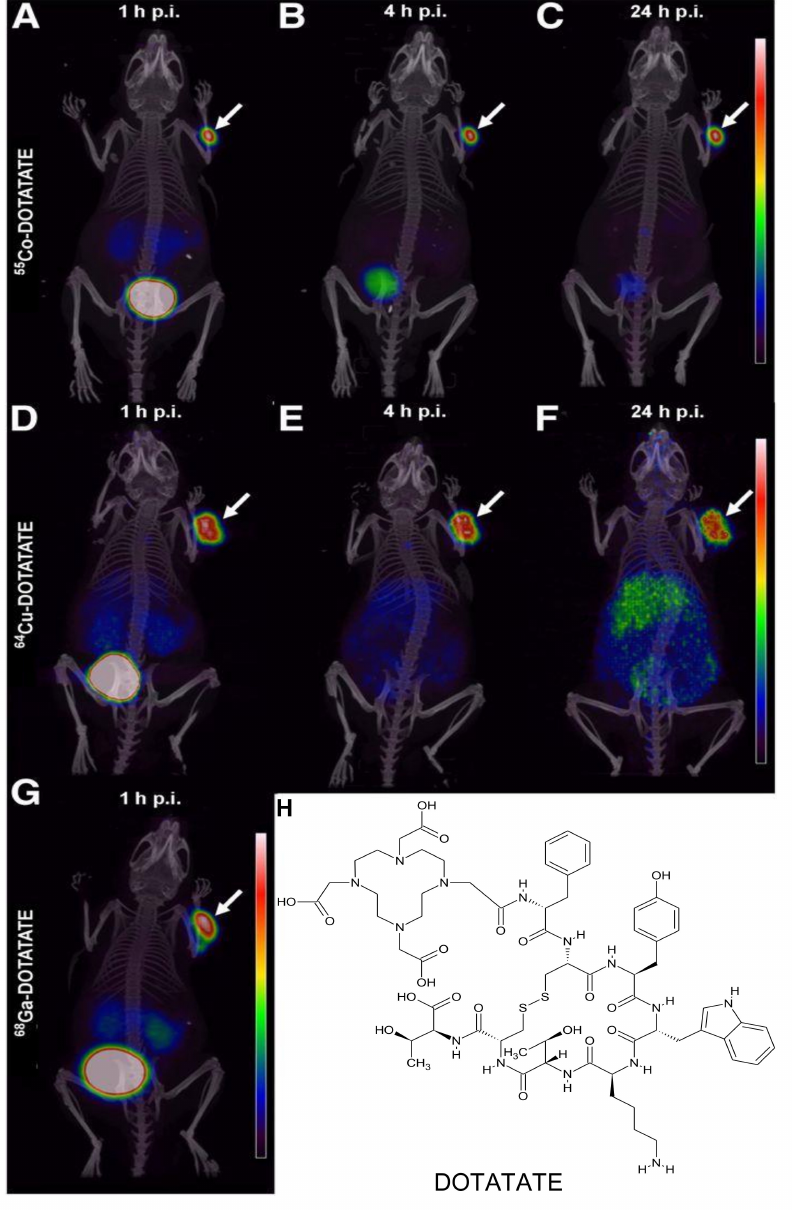
Figure 19. PET/CT scans comparing [ 55 Co]Co-DOTATATE ( A – C ), [ 64 Cu]Cu-DOTATATE ( D – F ), and [ 68 Ga]Ga-DOTATATE ( G ) in AR42J tumors. Imaging showed similar tumor uptake using all 3 agents at 1 h PI. Imaging at later timepoint images showed near-complete non-target clearance using [ 55 Co]Co-DOTATATE while [ 64 Cu]Cu-DOTATATE showed non-specific liver uptake